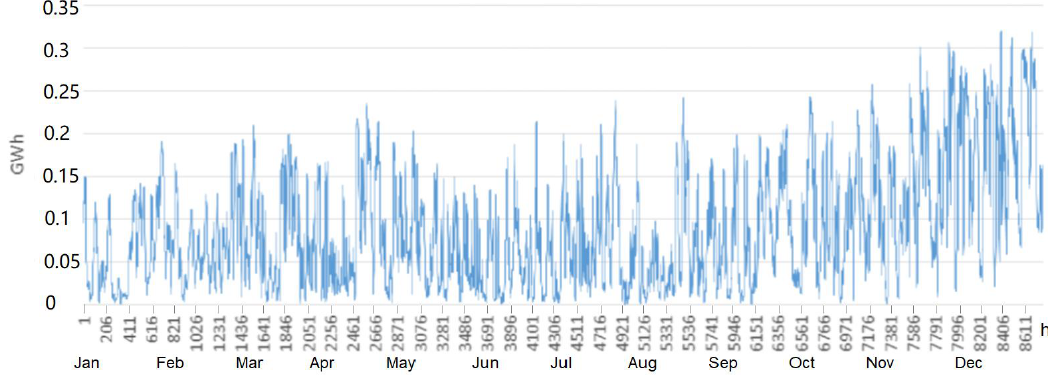
Figure 17. Hourly wind production in Finland.